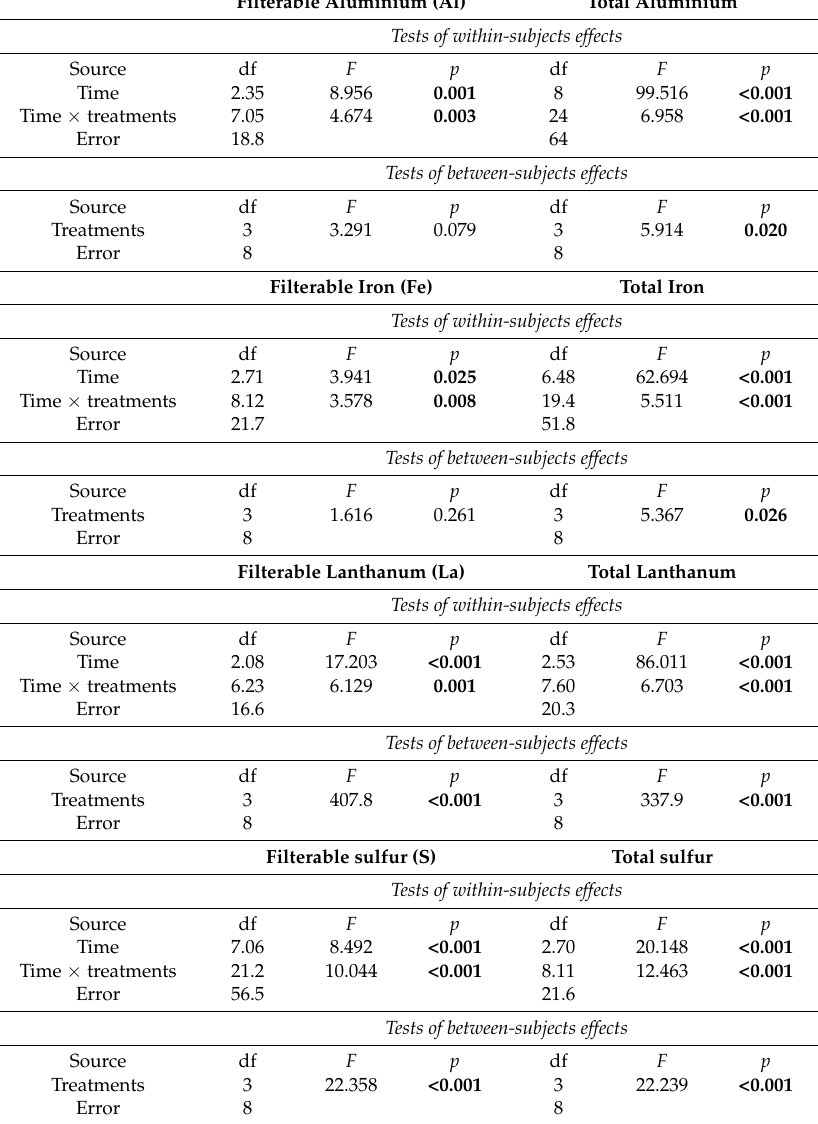
Table 2. Summary of repeated ANOVA measures for filterable and total metal concentrations (aluminum, iron, and lanthanum in µ g L − 1 ) and sulfur concentrations (mg L − 1 ) with treatments (dredging, LMB addition, and their combination) as the fixed factor. All data were log-transformed prior to analysis to fulfill the variance homogeneity requirements 1 . Significant differences ( p < 0.05) are indicated in